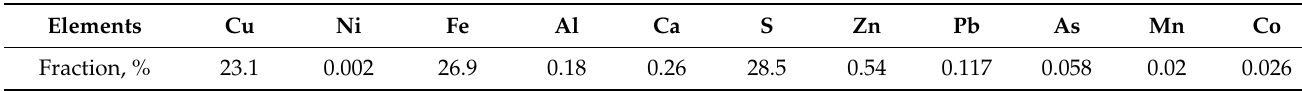
Table 2. Elemental composition of the chalcopyrite